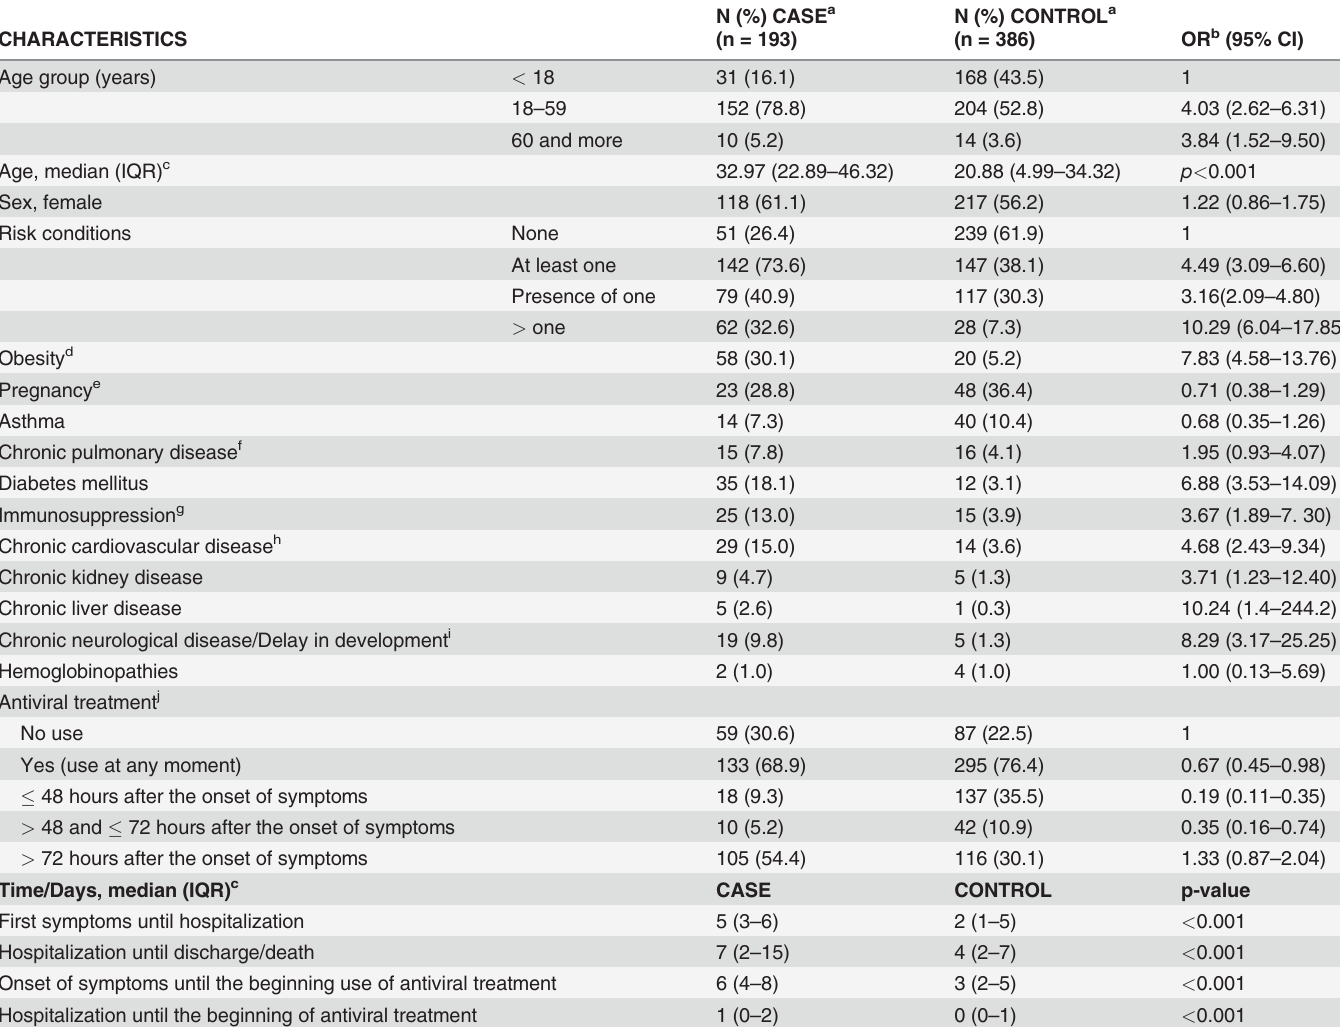
Table 2. Demographic and clinical variables of patients hospitalized due to in fl uenza A(H1N1)pdm09 associated with Severe Acute Respiratory Illness, who died (case) or recovered (control), metropolitan regions of S ã o Paulo and Campinas, state of S ã o Paulo, Brazil, 2009. N (%) CASE a N (%) CONTROL